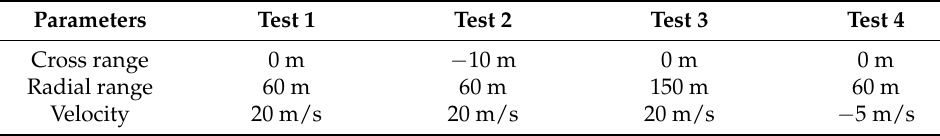
Table 1. Parameters of the dominant scatterer position. Parameters